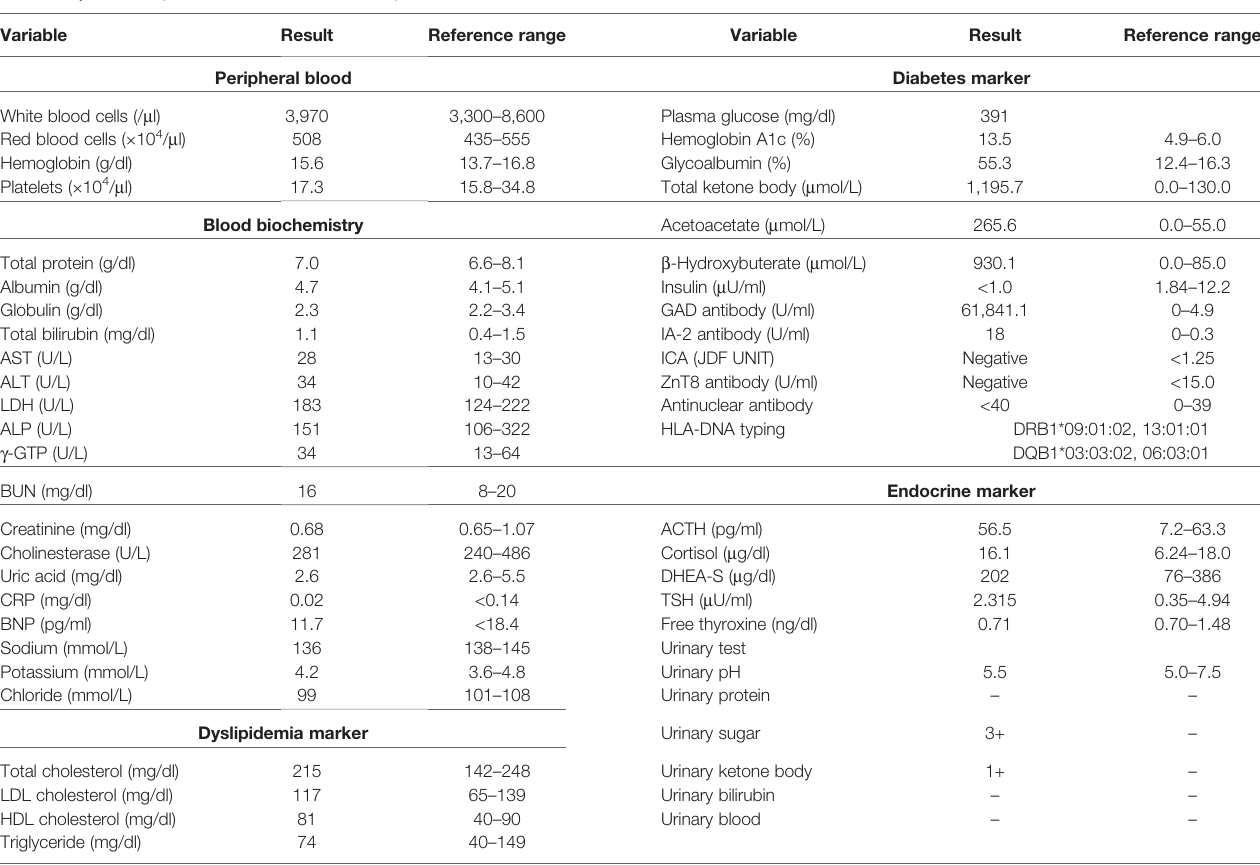
TABLE 1 | Laboratory data on admission in this